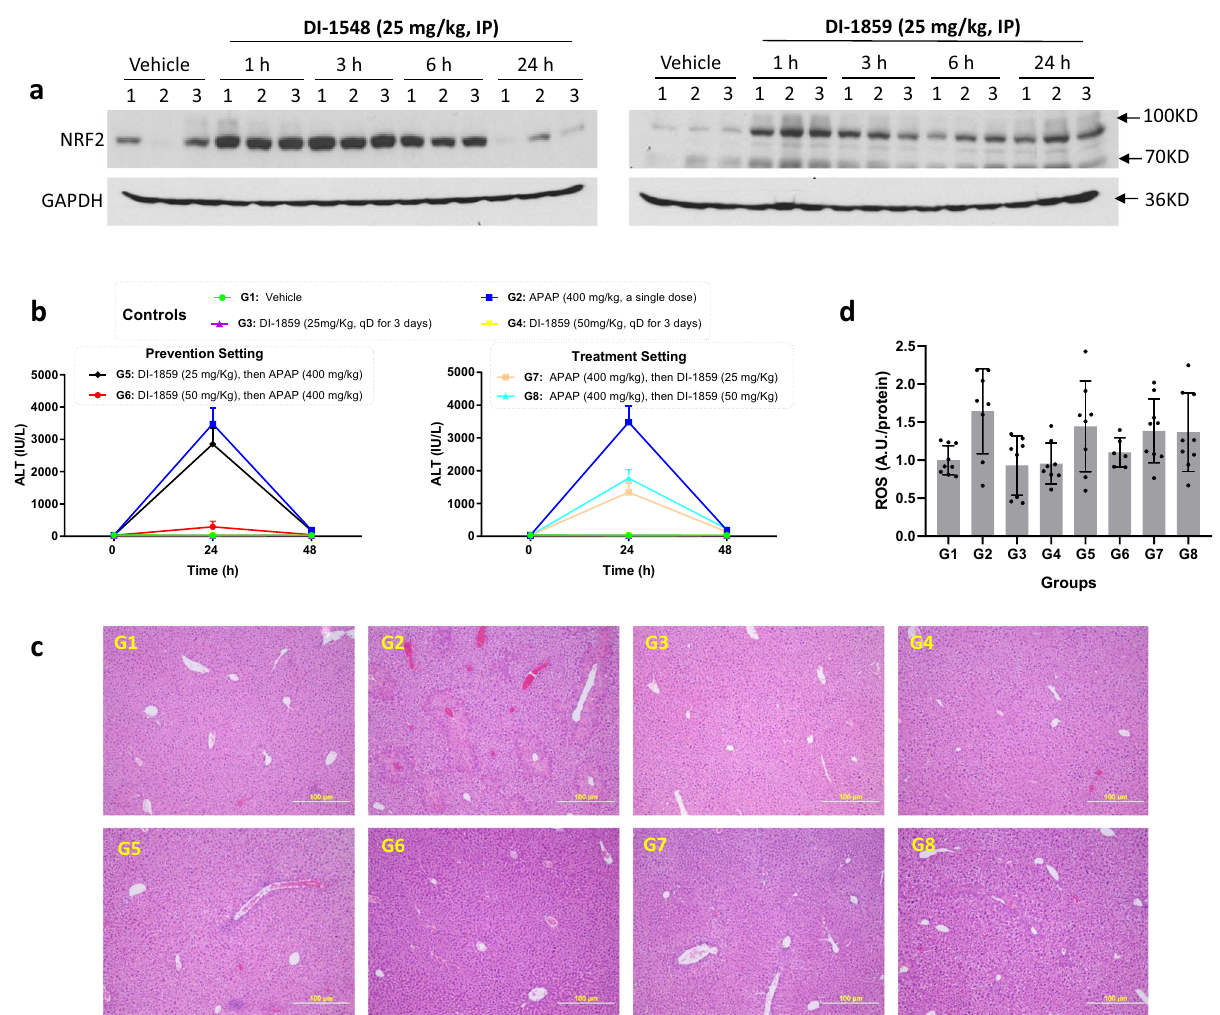
Fig. 7 DI-1859 effectively increases the level of NRF2 protein in the liver tissue and protects liver tissue damage induced by acetaminophen (APAP) in mice. a Western blotting analysis of the effect of DI-1548 or DI-1859 on the level of NRF2 protein in mouse liver tissue. Liver tissues harvested from C57BL/6 male mice treated with DI-1548 or DI-1859 at 25 mg/kg via intraperitoneal (IP) injection was lysed with RIAP buffer. The expression level of NRF2 protein was examined by western blotting. GAPDH was used a loading control. Representative images of two independent experiments are shown. b Analysis of the serum alanine aminotransferase (ALT) level in mice. The time (h) counted from APAP administration in G2 and G5-8, from DI-1859 or vehicle administration in G1, G3, and G4. Data are presented as mean ± s.d. with n = 9 (G1), 9 (G2), 8 (G3), 8 (G4), 9 G5), 9 (G6), 9 (G7), and 9 (G8). c Immunohistological analysis of mouse liver tissues. Images are representatives in each group. Images were taken with a 100× objective. Scale bar: 100 µ m. d Analysis of the ROS level in mouse liver tissue. Data are presented as mean ± s.d. with n = 9 (G1), 8 (G2), 8 (G3), 8 (G4), 8 (G5), 6 (G6), 9